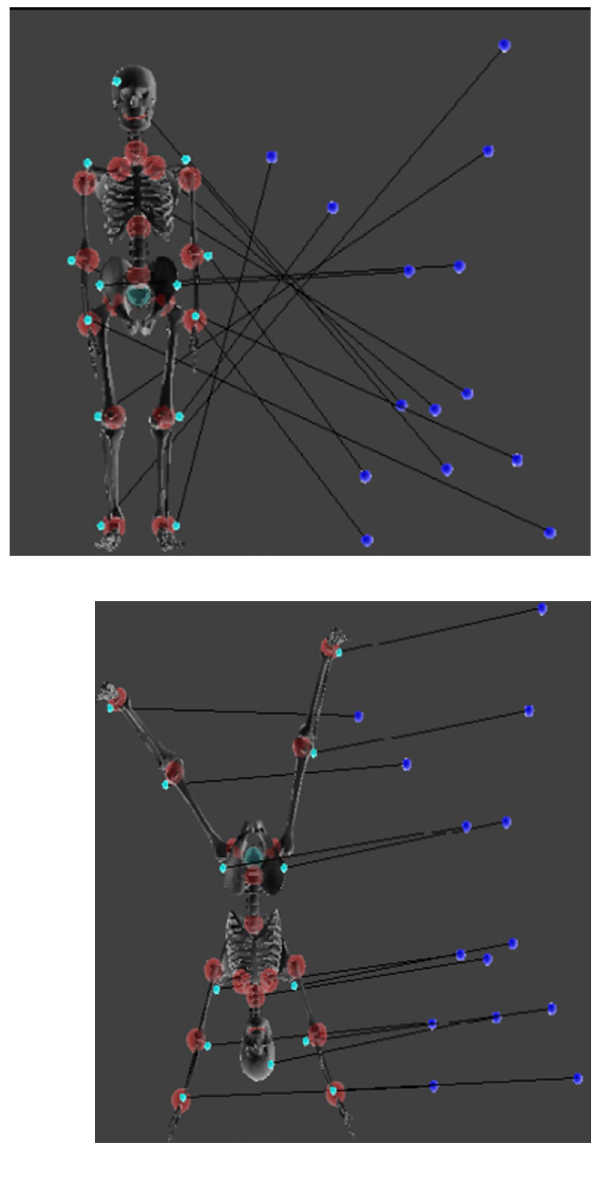
Fig. 4 Human body model and initial guidance point